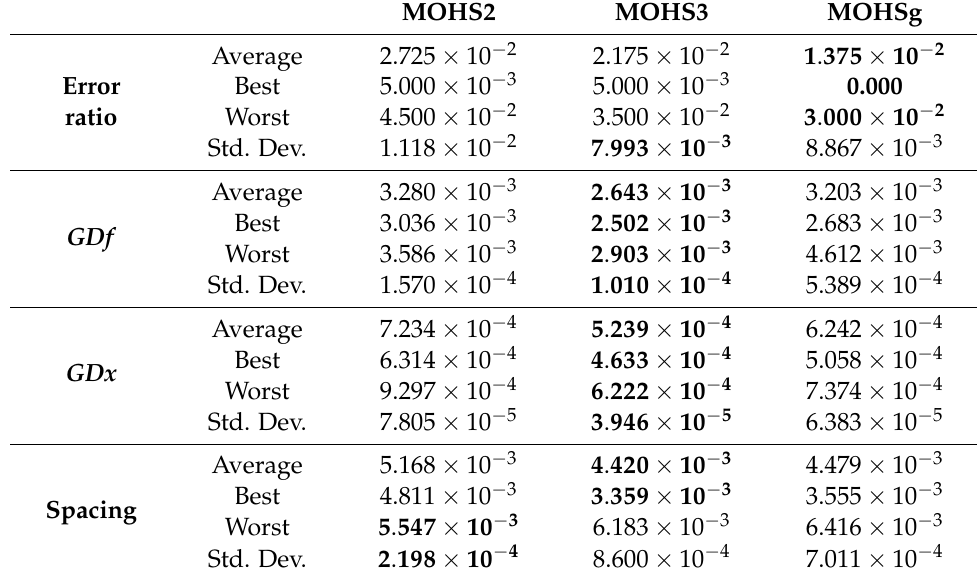
Table 6. Statisticalanalysis for problem P4.